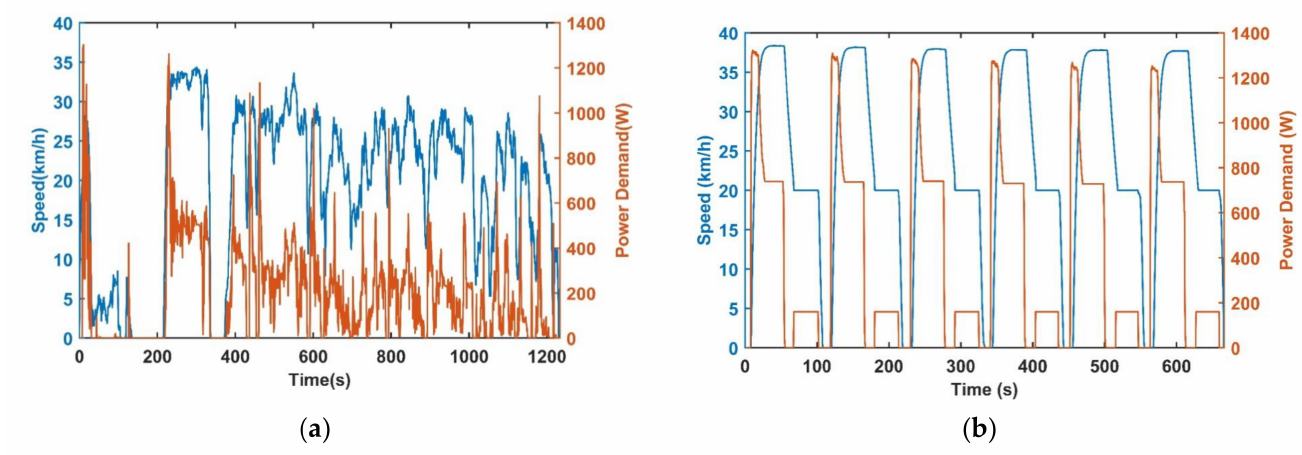
Figure 4. Driving speed and power demand of two typical driving cycles: ( a ) Driving speed and power demand of the Shanghainese urban driving cycle; ( b ) Driving speed and power demand of the Chinese standard test